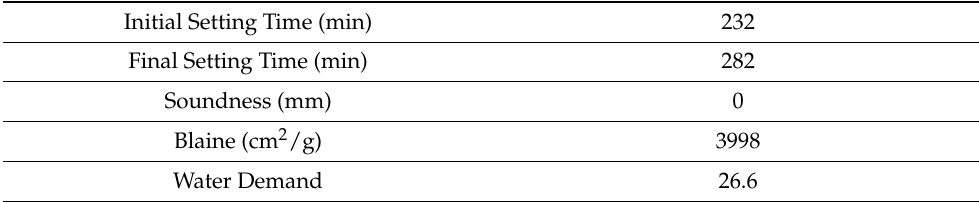
Table 2. Physical properties of the cement.